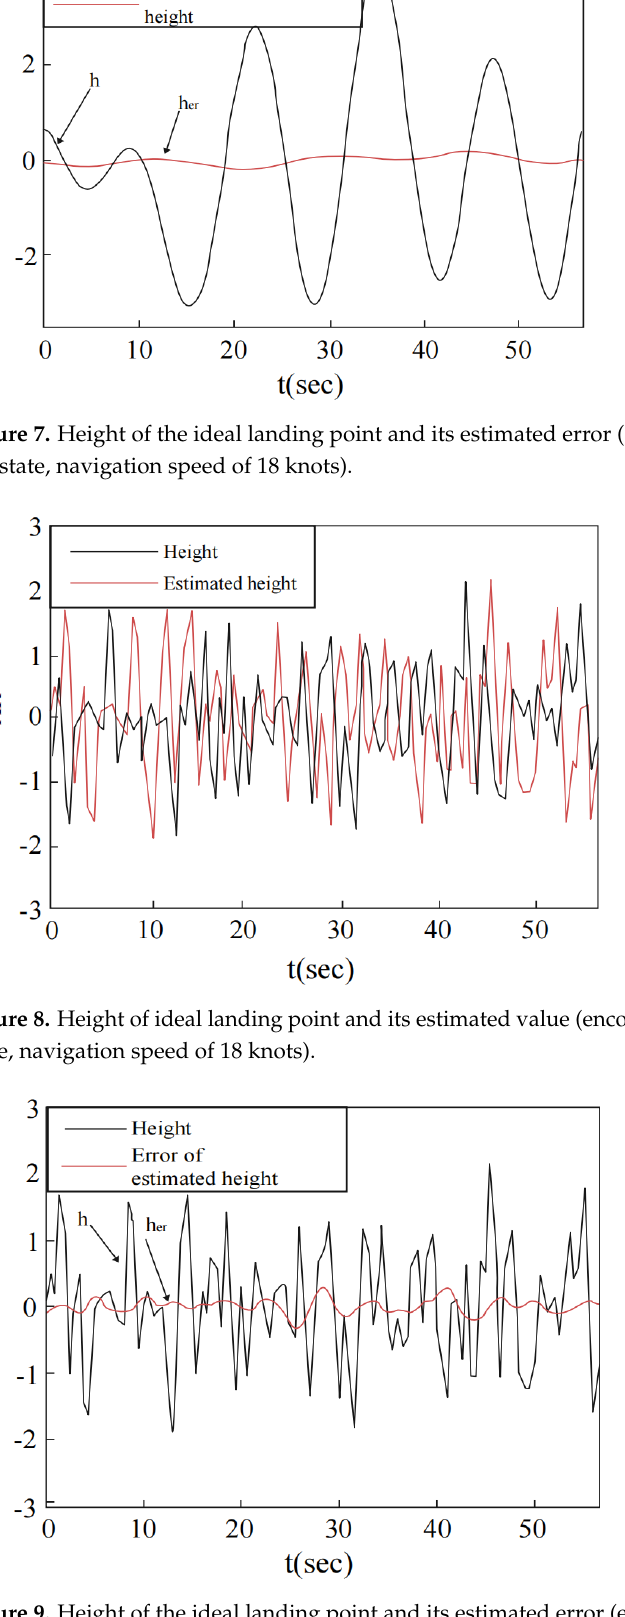
Figure 9. Height of the ideal landing point and its estimated error (encounter angle of 2 π /3, level − 5 sea state, navigation speed of 18 knots ).